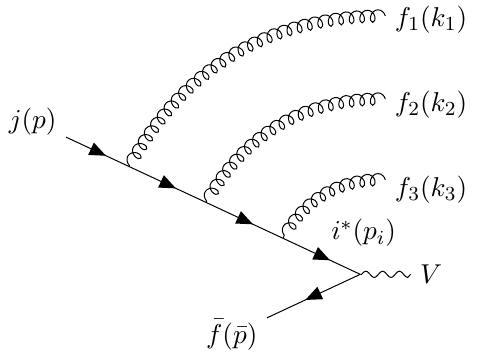
Figure 1 . Sketch of a triple-real contribution to the process j ( p ) + ¯ f (¯ p ) → V + f 1 ( k 1 ) + f 2 ( k 2 ) + f 3 ( k 3 ) , for j = q , ¯ f = ¯ q and f 1 , 2 , 3 = g , to illustrate the notation for the momenta and